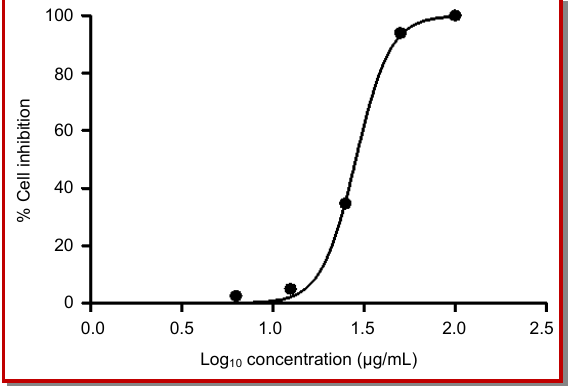
Figure 1 : Cytotoxic effect of O. stamineus ethyl acetate fraction 3 on MCF-7